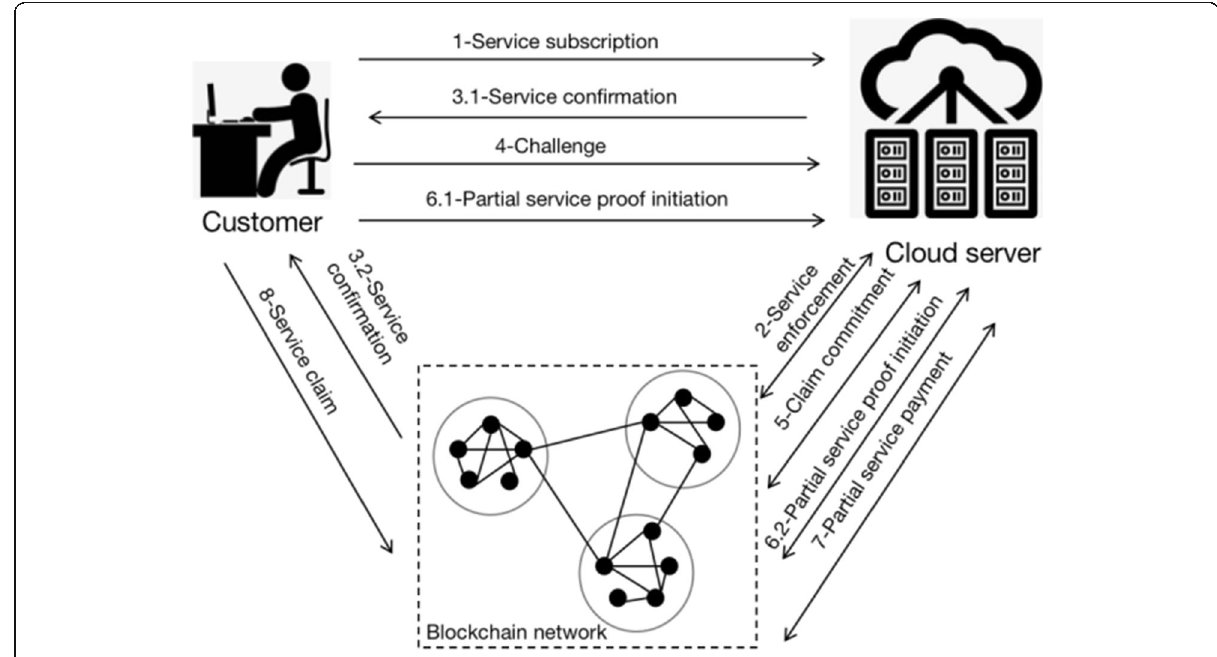
Fig. 9 Life cycle of a typical outsourcing service in BPay